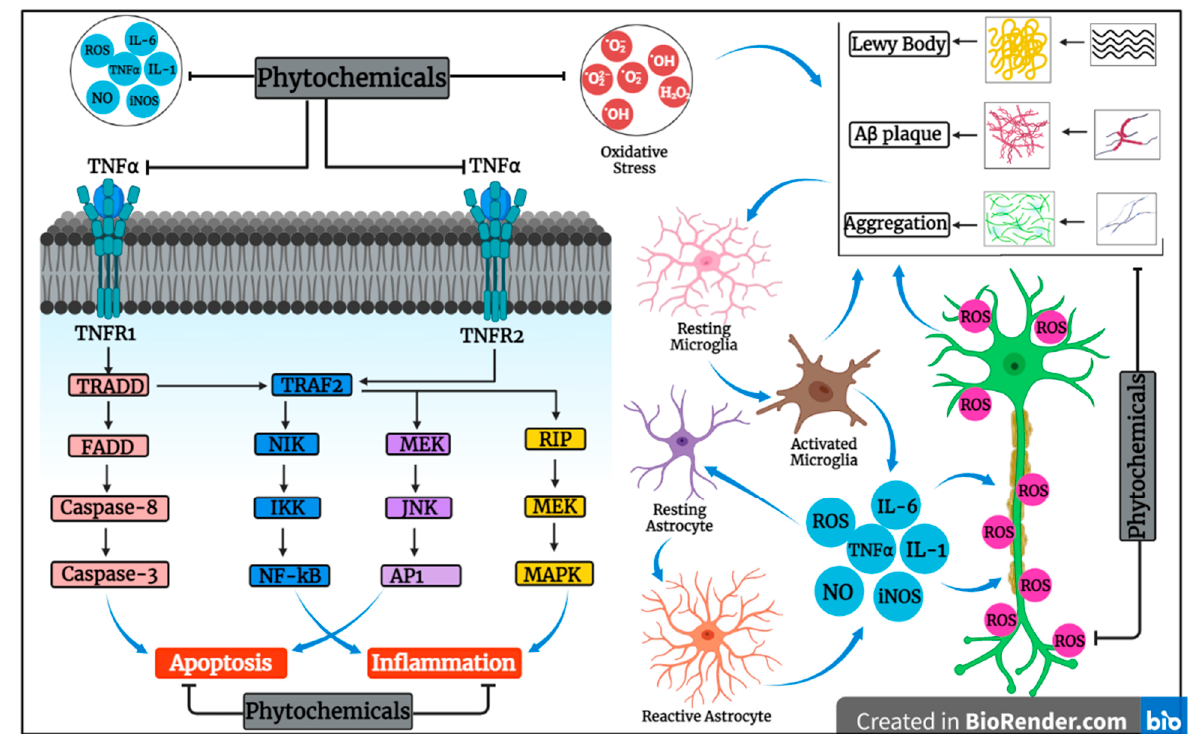
Figure 2. Oxidative stress due to the production of reactive oxygen species may lead to neuro- degeneration. Activated microglia and reactive astrocyte generate ROS, pro-inflammatory cyto- kines, and inducible nitric-oxide synthase (iNOS), which may cause further damage. Binding of TNF- α to its receptor can lead to the activation of many signaling pathways, which may cause apoptosis induction and inflammation. On the other hand, phytochemicals have great ability to target apoptosis, inflammation, and oxidative stress, as depicted in the figure.